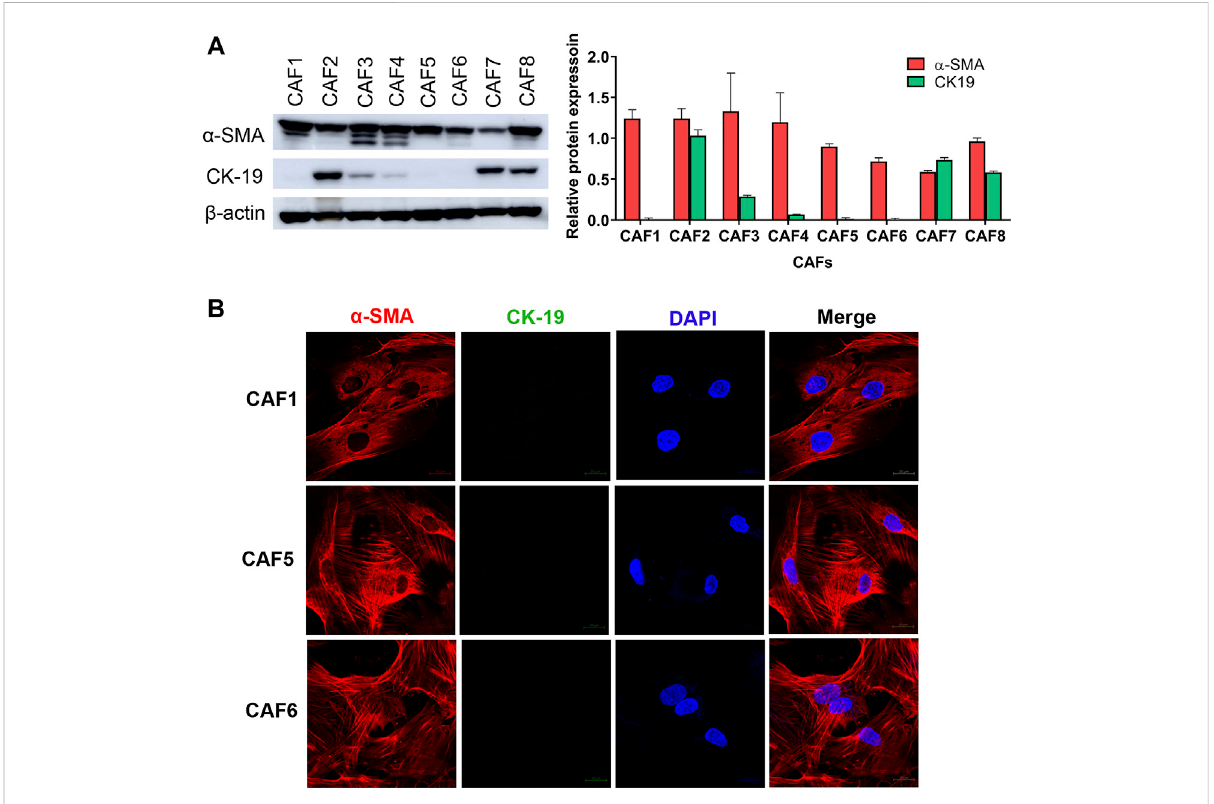
FIGURE 1 CharacterizationofCAFsbywesternblottingandimmuno fl uorescencestaining. (A) Western blotanalysis showsthelevelsof α -SMAandCK-19 inprimarilyisolatedCAFs. (B) CAFsdisplayedaspindle-likemorphologyby α -SMAstainingobservedunderconfocalmicroscopy.Hoechst33342was used for visualizing the nuclei of CAFs. Green, stained with cytokeratin-19 (CK-19); red, stained with α -SMA and blue, stained with Hoechst 33342. Original magni fi cation is